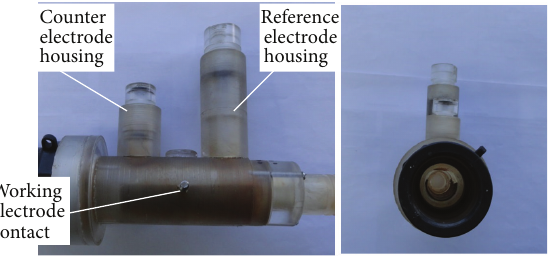
Figure 2: Cylindrical cell utilized in flow conditions.